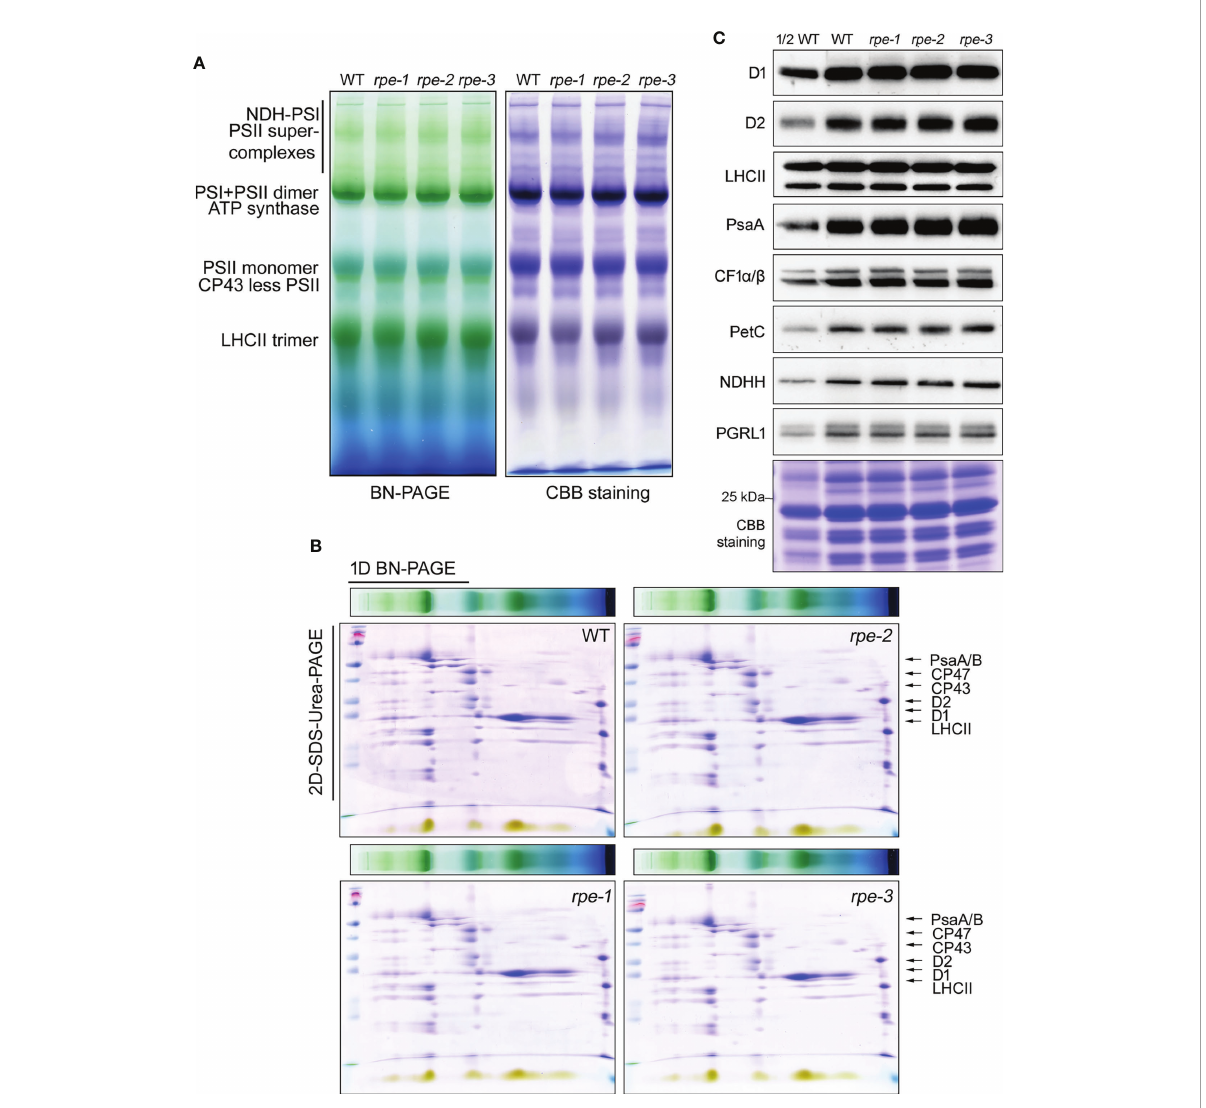
FIGURE 3 Analysis of the photosystem complexes and their core proteins in WT and the rpe mutants. (A, B) BN-PAGE (B) and 2D SDS-Urea-PAGE (C) analysis of the thylakoid protein complexes. Thermo Scienti fi c PageRuler Prestained Protein Ladder is used for the protein molecular weight marker (Thermo, 26616). (C) Immunoblot analysis of representative thylakoid proteins. Thylakoid membranes isolated from the WT and the rpe mutants were separated by 15% SDS-Urea-PAGE and then probed with antibodies against individual subunits of PSII (D1, D2 and LHCII), PSI (PsaA), chloroplast ATP synthase (CF 1 a / b ), Cyt b 6 f (PetC), NADH dehydrogenase-like complex (NDHH), and PGR5/PGRL1 complexes (PGRL1). Thylakoid proteins containing equal amounts of chlorophyll were